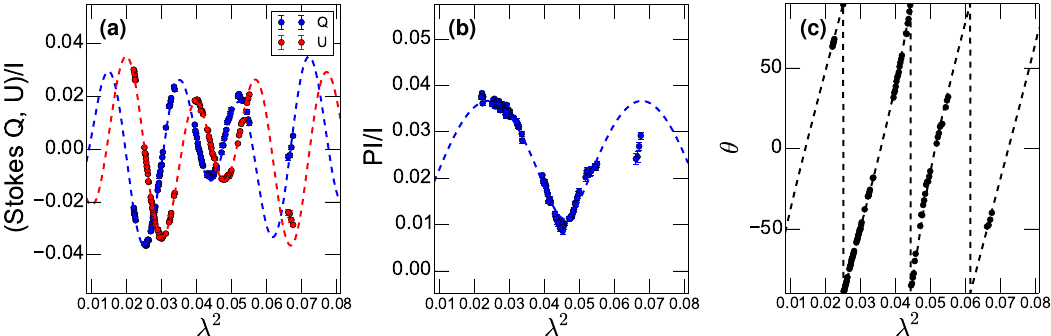
Figure 2. QU -fitting results of NVSS J190255+315942, with ( a ) Q / I and U / I against λ 2 , ( b ) polarisation fraction against λ 2 , and ( c ) polarisation angle (PA) against λ 2 . The dotted lines represent the best-fit model for the source (see